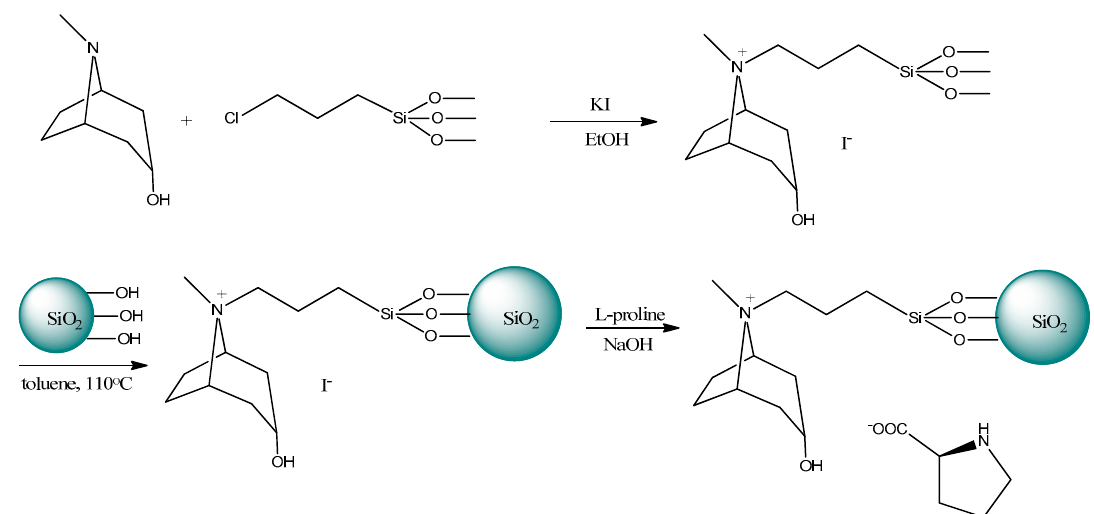
Figure 10. Synthetic route of the SG- L -PhAlaC 2 NTf 2 phase (adapted from Marwani, 2014) [172]. In 2016 Yao et al. [173] described the chemical bonding method for immobilization of the chiral tropine IL with ( S )-proline anion on the surface of silica gel. The procedure of silica gel modification is presented in Figure 11.